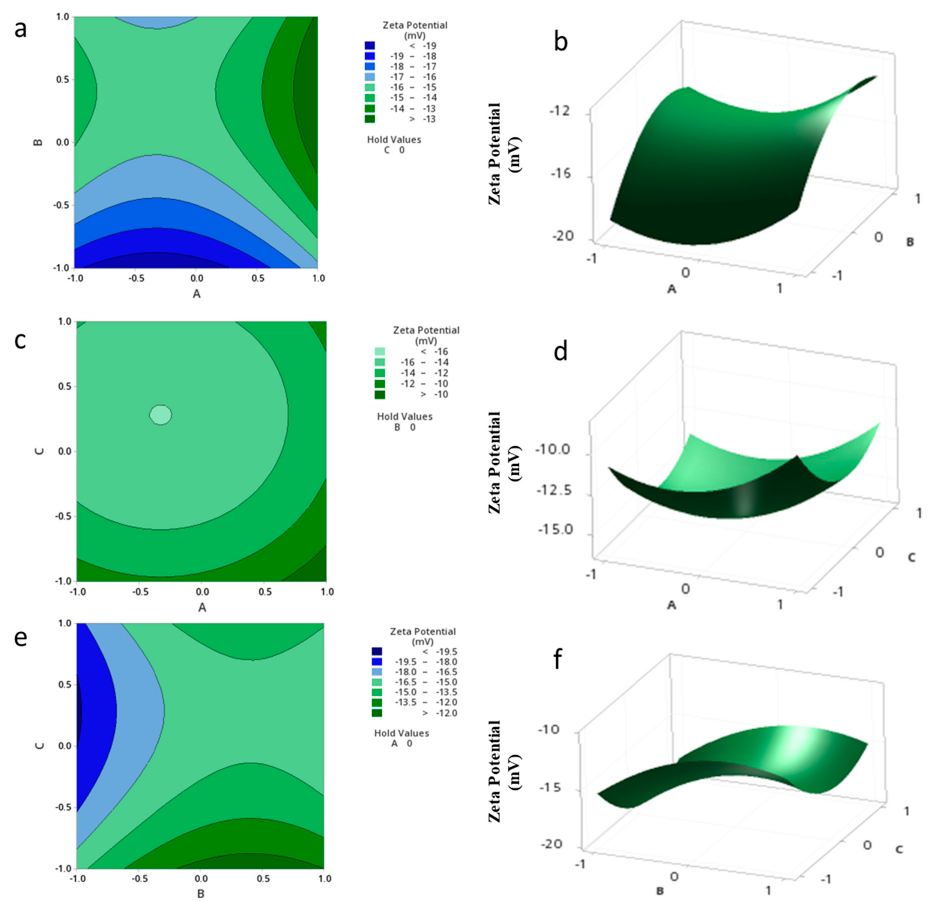
Figure 5. Contour plots ( a , c , e ) and Surface plots ( b , d , f ) showing the e ff ect of variables (A–C) on the charge of the NPs. The highest signi fi cant e ff ect was shown to be the squared concentration of the sur- factant (C 2 ) with 24.84% contribution.